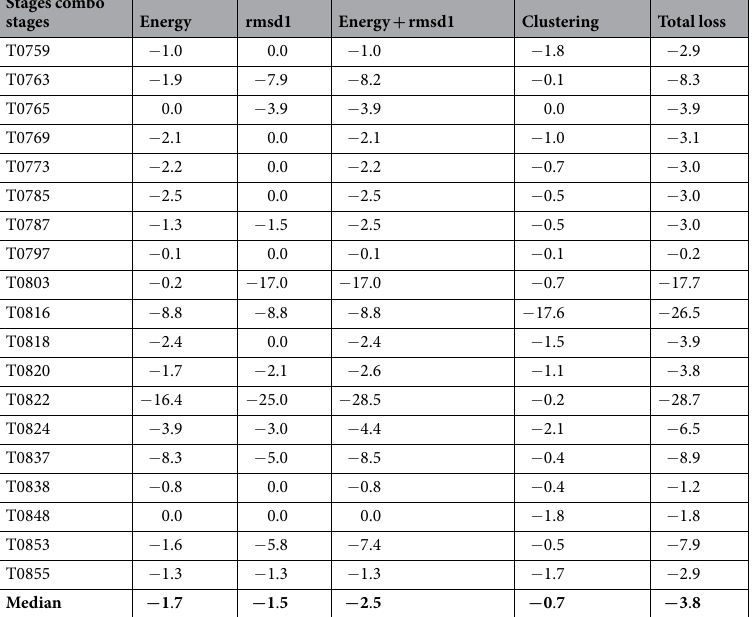
Table 3. The GDT_TS loss for the different steps in the complete clustering process for T0XXX targets, as measured by comparing the GDT_TS difference between the best GDT_TS before and after the different stages; energy is loss after applying the Rosetta energy filter cutoff, rmsd1 is the loss after applying the filter that excluded models too different from the lowest Rosetta energy model, energy + rmsd1 is the cumulative loss by applying both energy and rmsd1 filters, clustering is the loss after clustering, and Total loss refers to the complete cumulative loss after both filtering and clustering.